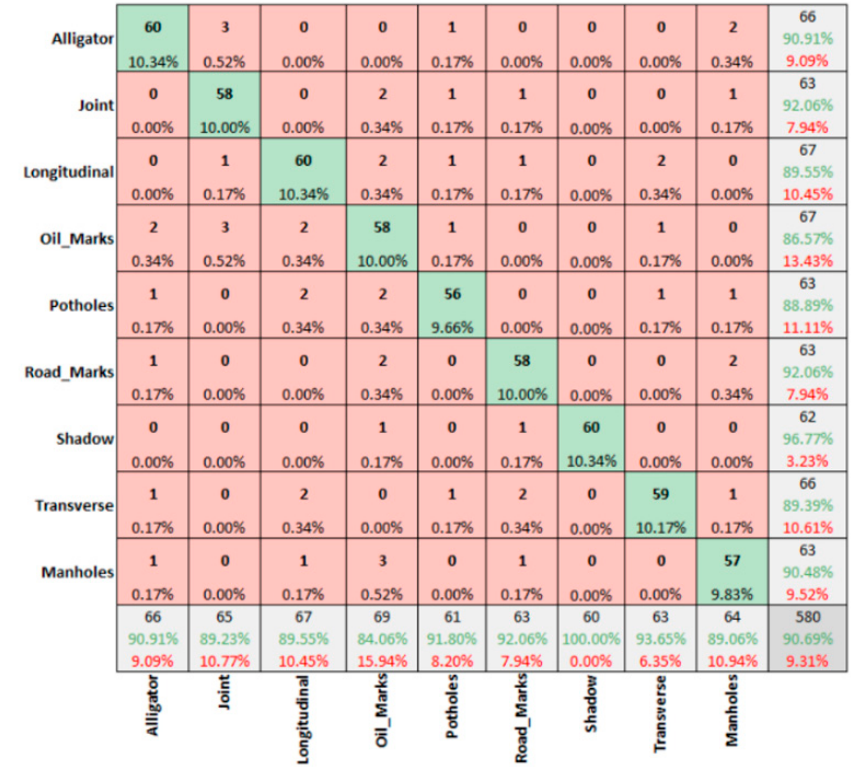
Figure 12. Winter sunny condition—MSX images.